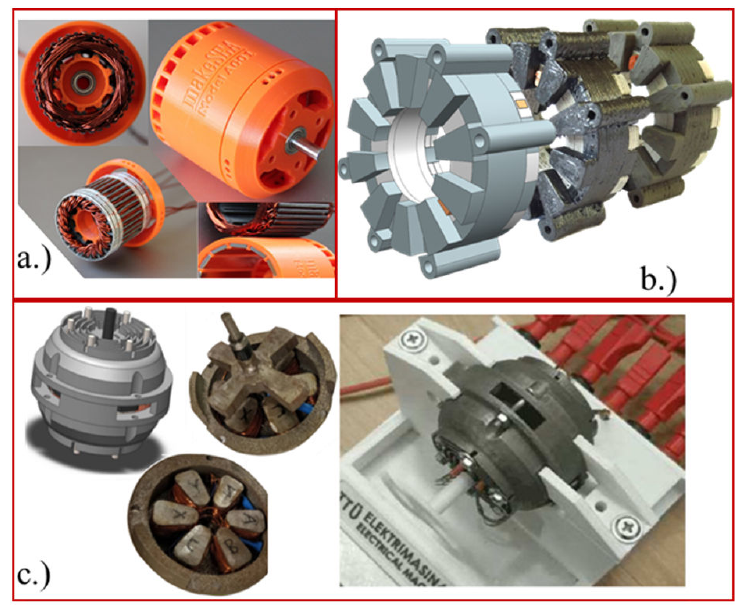
Figure 7. Examples of AM-built electrical machines ( a ) halbach array DC motor [72] ( b ) stator of end-winding reluctance machine [17] ( c ) Prototype Axial-Flux SRM [73].